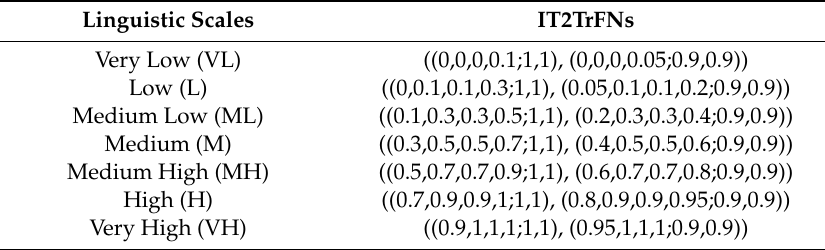
Table A9. Linguistic scales and fuzzy numbers for the alternatives.